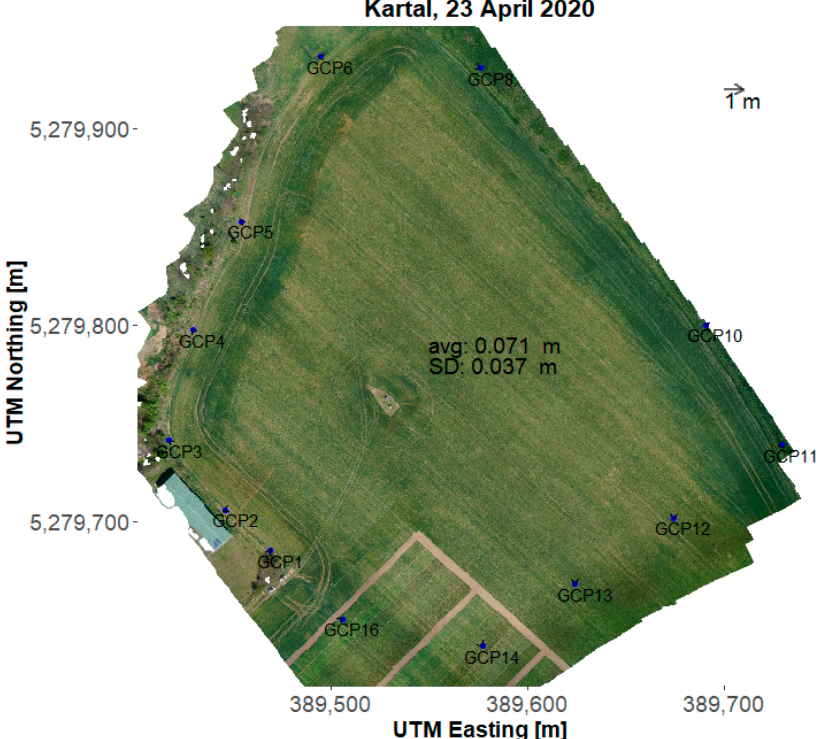
Figure 5. RGB orthomosaic from the Kartal (cropland) site taken on 23 April 2020. The GCPs on the RGB are highlighted with blue dots. The arrows point to the position where they should be according to their measured (STONEX S8) coordinates. The length of the arrays is multiplied by 10 for illustrative purposes, i.e., the arrow indicating 1 m length at the top of the image means 10 m at the